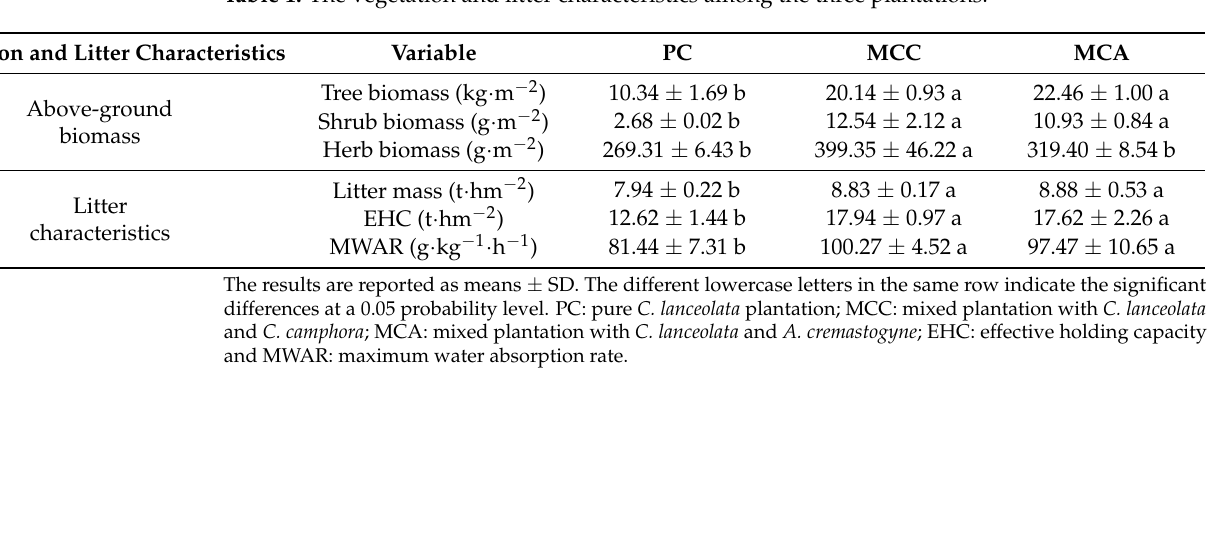
Figure 5. Correlation analysis of the CRSW with the vegetation and soil properties under the three rainfall events. PC-AGB: the first component from the principal components analysis of the above-ground biomass (TB, SB and HB); PC-LP: the first component from the principal components analysis of the litter properties (LM, EHC and MWAR); PC-SP: the first component from the principal components analysis of the soil properties (BD, TP and FC); RB: root biomass; CLRSW: the contribu- tion of light rainfall to soil water; CMRSW: the contribution of moderate rainfall to soil water and CHRSW: the contribution of heavy rainfall to soil water; * p < 0.05, ** p < 0.01, *** p < 0.001. Table 1. The vegetation and litter characteristics among the three